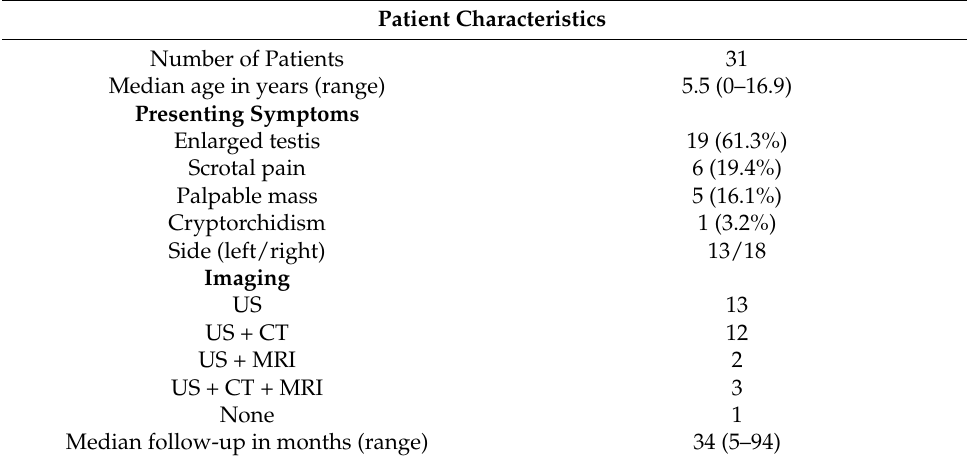
Table 1. Clinical characteristics of the study